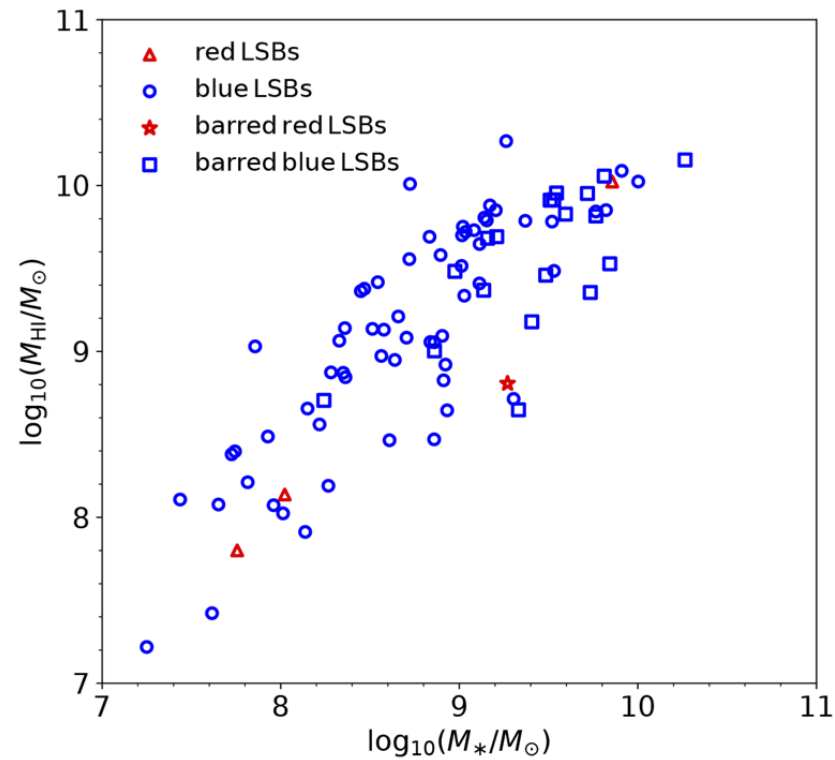
Figure 8. The HI disk mass M HI vs. the stellar disk mass M (cid:63) for LSBs of different morphologies. Reproduced from [196].